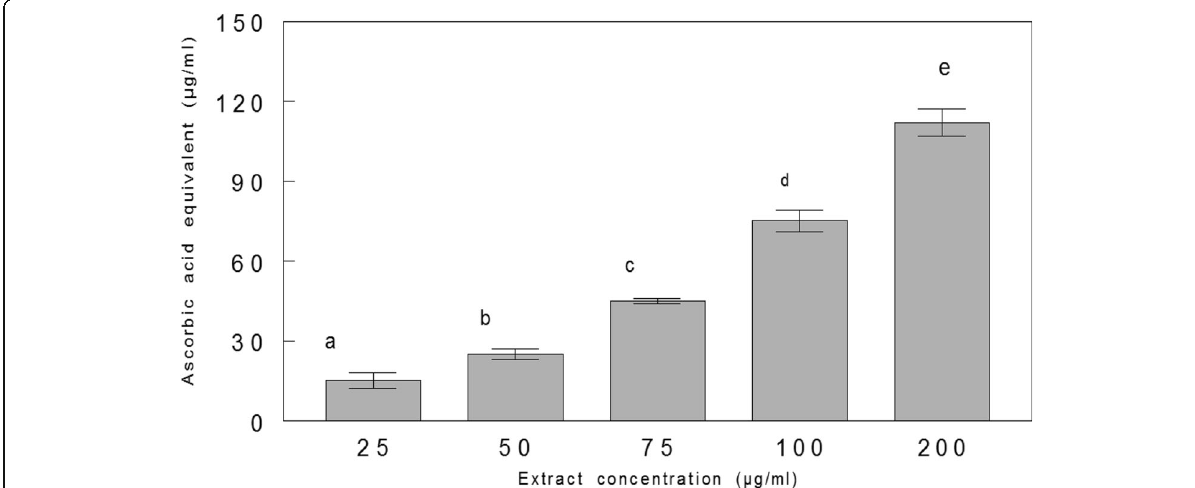
Fig. 5 Total antioxidant activity of Terminalia chebula fruit extract. Values are means±SD ( n = 3). Values in figures which share different letters are significantly ( p < 0.05) different from each other by DMRT